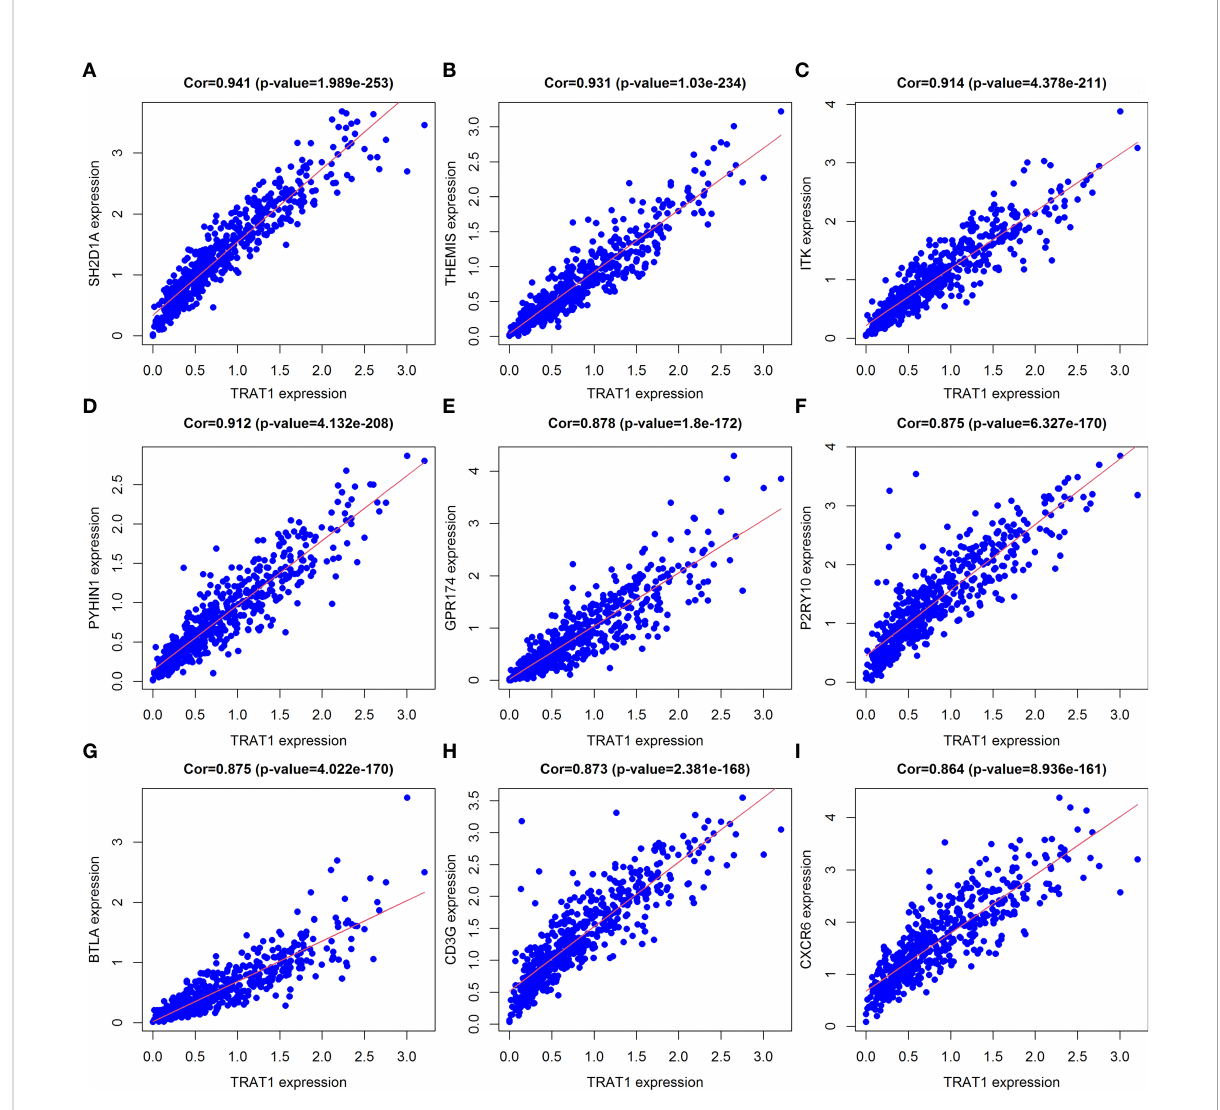
FIGURE 3 Top 9 TRAT1 co-expressed genes. (A) SH2D1A ; (B) THEMIS ; (C) ITK ; (D) PYHIN1 ; (E) GPR174 ; (F) P2RY10 ; (G) BTLA ; (H) CD3G ; (I) CXCR6